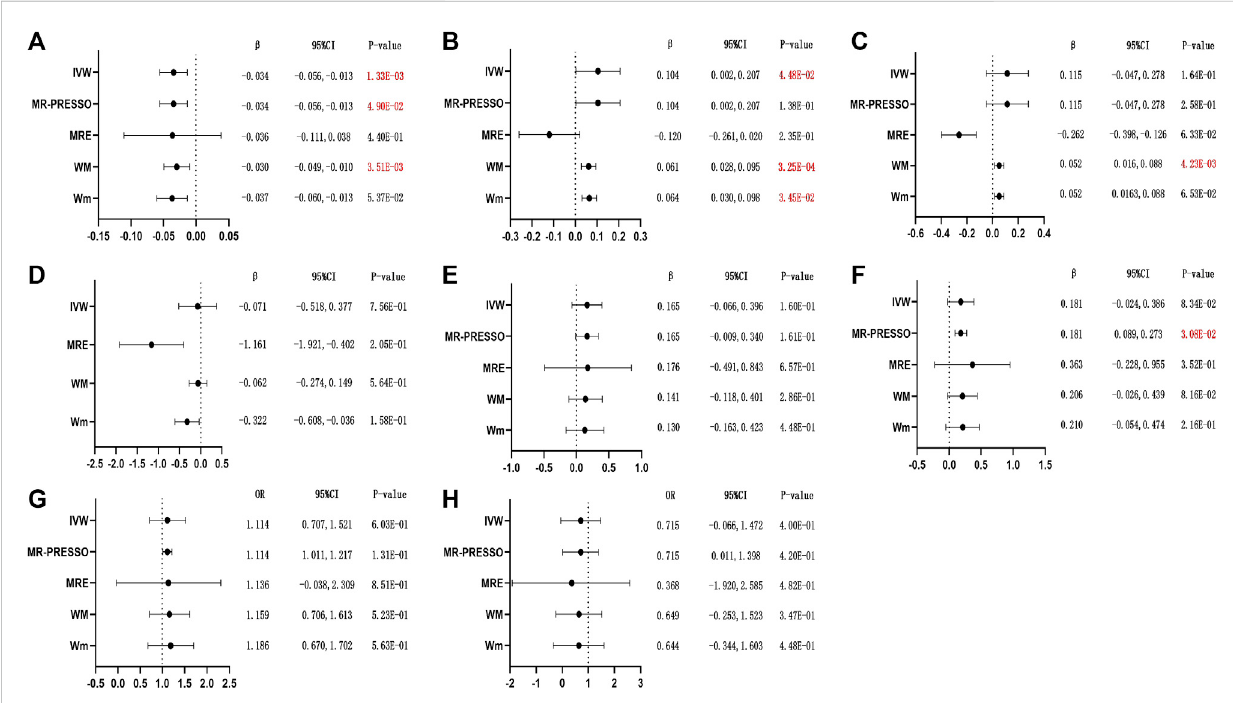
FIGURE 3 MR results of causal effects of coffee consumption SNPs on related outcome risks. (The estimates were derived from the random-effects IVW model, the MR-PRESSO approach, MRE regression, WM, and Wm. (A – H) : (A) SHBG; (B) bio-T; (C) TT; (D) E 2 ; (E) AMH; (F) age at menopause; (G) irregular menstrual cycle/bleeding; and (H) dysmenorrhea. Outliers of MR-PRESSO: none or not available. p -values < 5.00E-02 are presented in red, and red and bold font means p -values < 2.08E-03. β , beta; CI, con fi dence interval; OR, odds